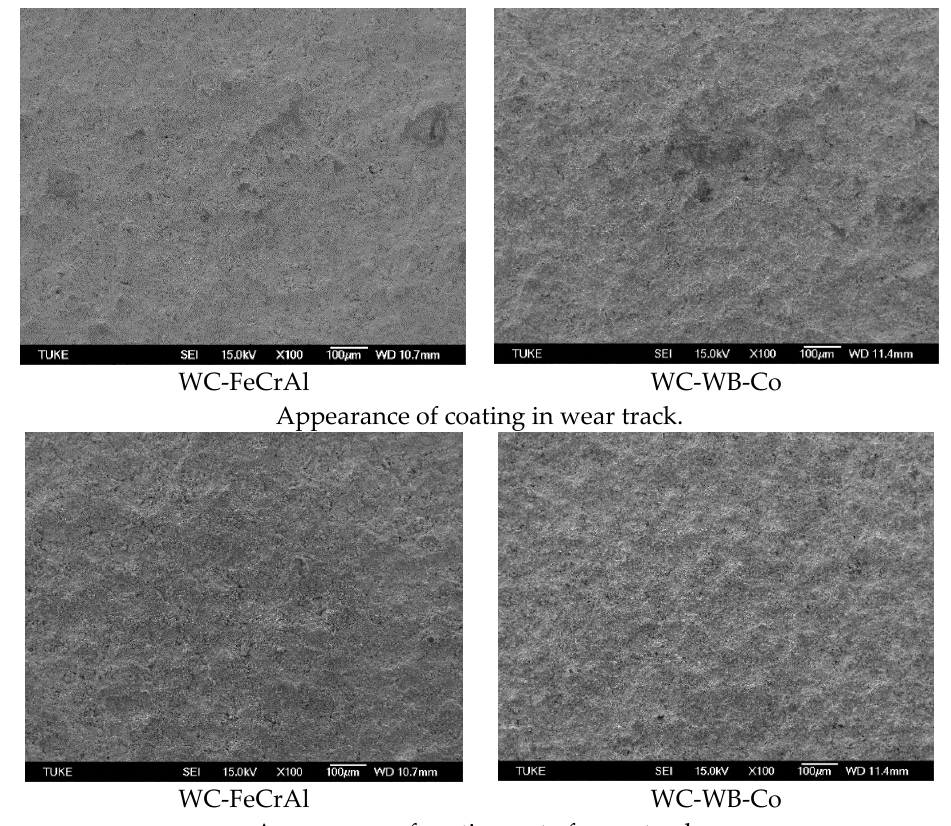
Figure 16. Appearance of coatings’ surfaces in and out of wear track (SEM).